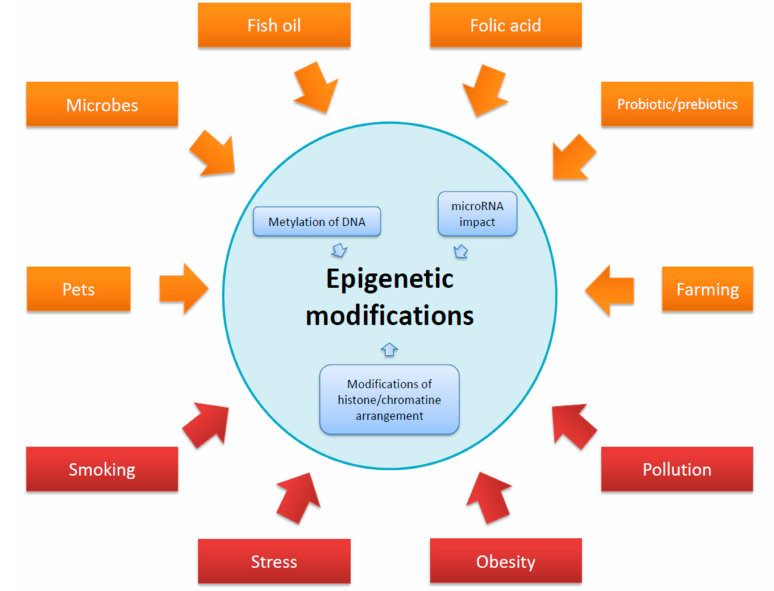
Figure 3. Factors acting on the body of a pregnant woman and a ff ecting the epigenome of a child. All factors could have a modifying e ff